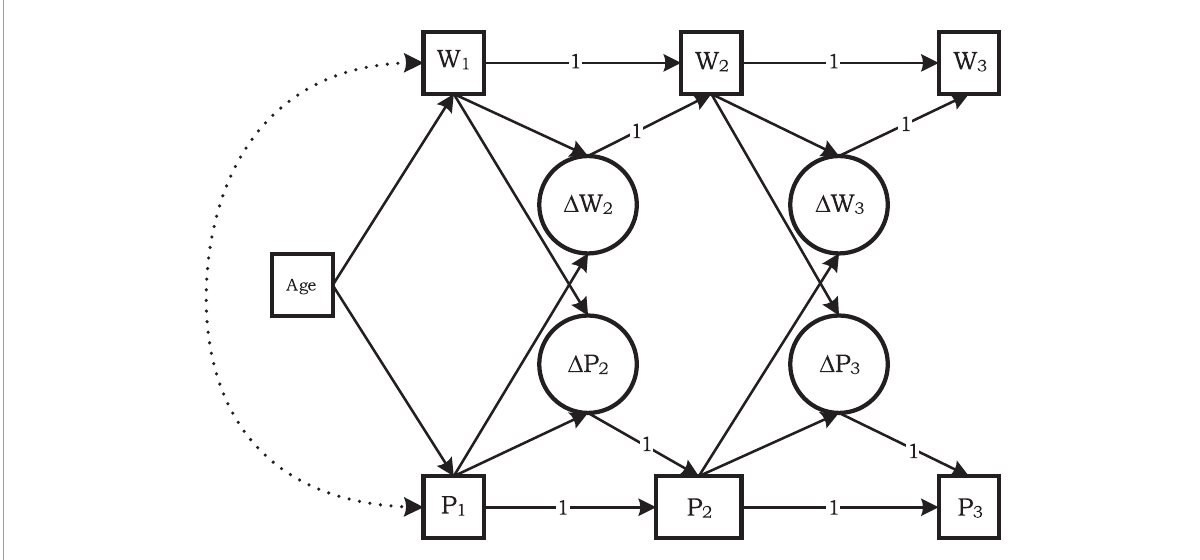
FIGURE4 Bivariate change score model of Word and Pseudoword decoding Efficiency for the first cohort of students, grades 1–3. W1 is Word decoding Efficiency and P1 is Pseudoword decoding Efficiency observed at the end of Grade 1; (cid:49) W2 is the change score in W2. Paths with a coefficient of 1 were fixed at a value of 1; all other paths had a coefficient to be estimated. Intercepts and residual variances and covariances